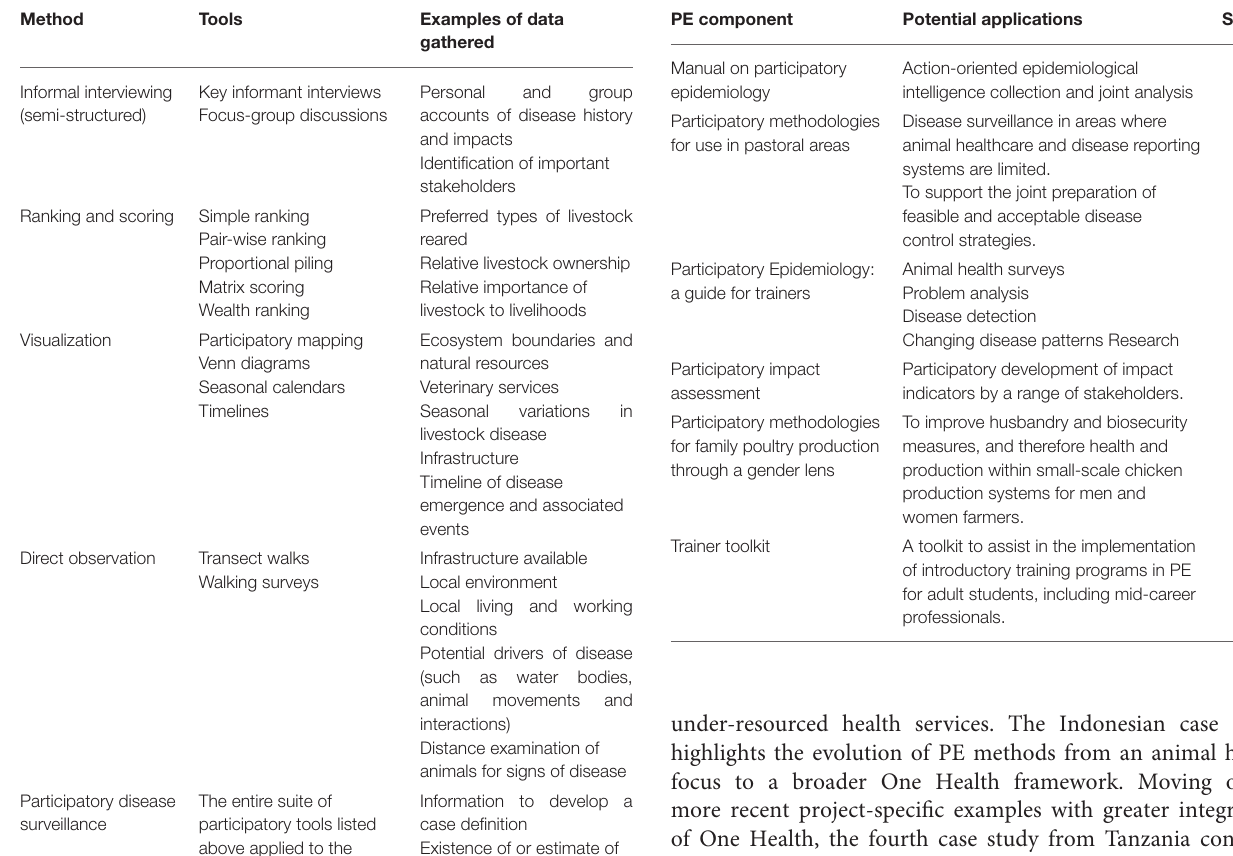
TABLE 2 | An overview of the most commonly used PE methods and tools used to obtain specific information.